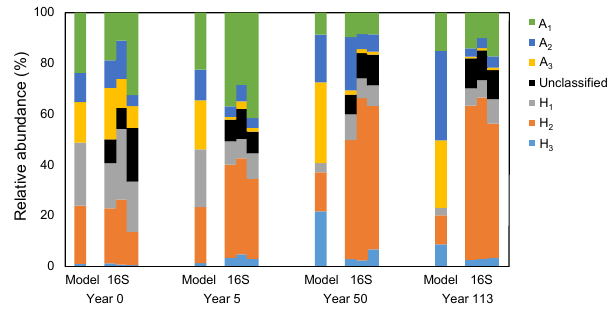
Figure 8. A comparison of microbial diversity from model output and genomic analyses at 0-, 5-, 50-, and 113-year-old